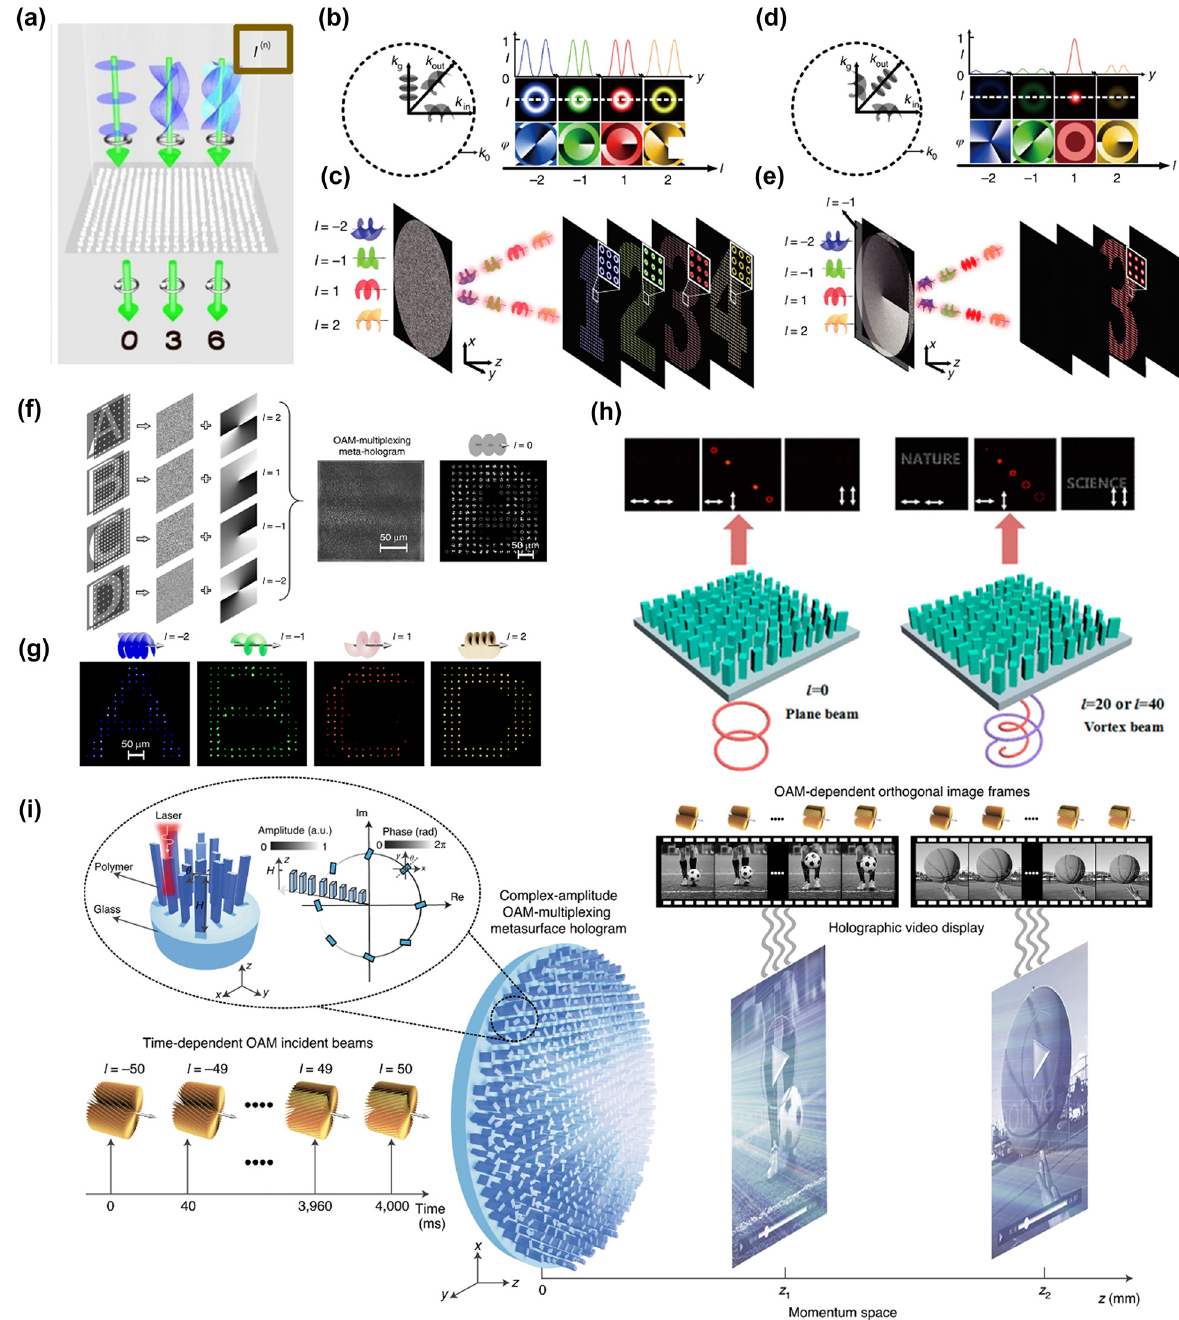
Figure 6: Metasurface for OV holography. (a) Meta-transformer utilizing OAM as an additional degree of freedom [97]. (b) Schematic of OAM property transfer in the spatial frequency domain ( k -space) [97]. (c) OAM conserving meta-hologram that preserves the OAM property to the image plane [97]. (d) Schematic of OAM conversion after passing OAM selective hologram in the spatial frequency domain [100]. (e) OAM selective meta-hologram that constructs images at target OAM modes [97]. (f) Design of an OAM-multiplexing meta-hologram [99]. (g) Experimental result of an OAM-multiplexing meta-hologram [99]. (h) Vortex and polarization multiplexed meta-hologram [103]. (i) Schematic of complex-amplitude metasurface-based OAM-multiplexing hologram